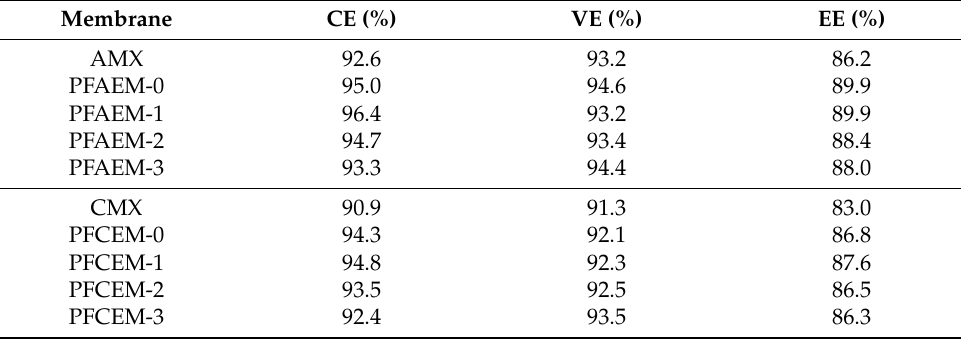
Table 6. Battery efficiencies of commercial membranes and